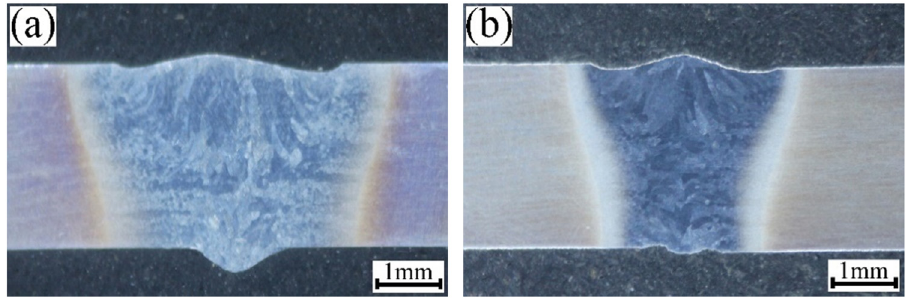
Figure 5: Cross section pro fi le of the welded joint: ( a ) EBW joint and ( b ) P -